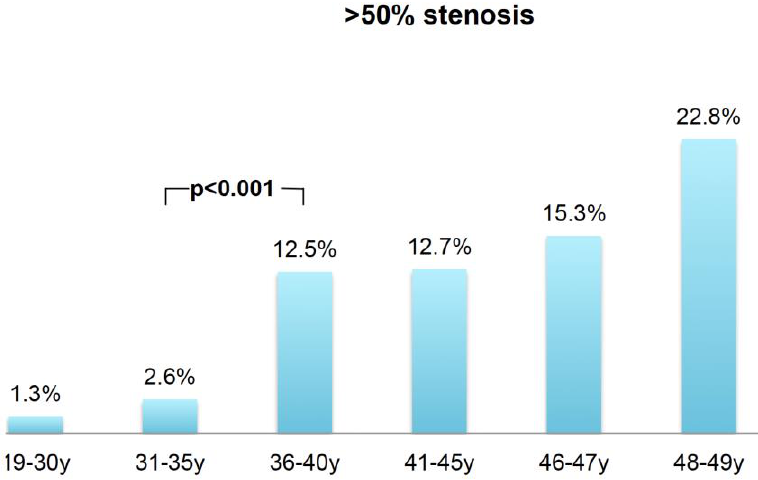
Figure 3. Obstructive coronary artery disease (>50% stenosis) based on CTA: Prevalence increased in patients older than 35 years of age ( p < 0.001). High-risk plaque prevalence was low with 6.5% in the youngest age group 1 and increased linearly to 26.5% in group 6. Stepwise testing revealed no significant increase between all groups. (Figure 4)